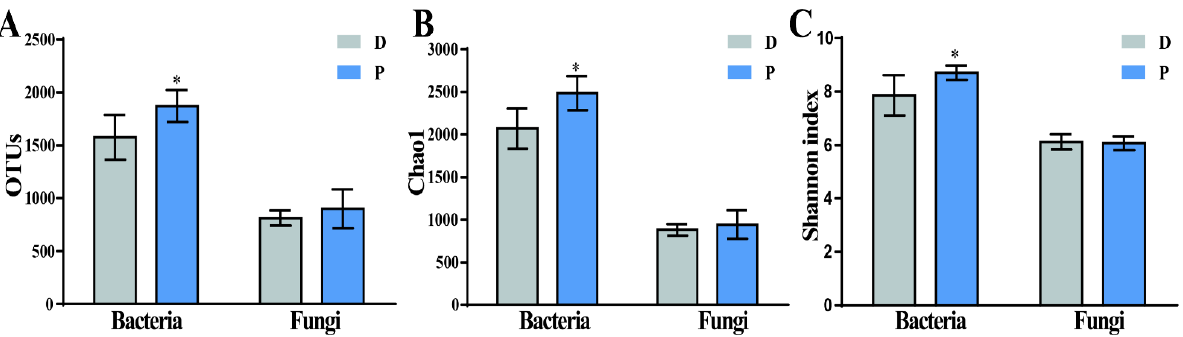
Figure 1. Effect of the fungicide prochloraz on bacterial and fungal community diversity in bayberry rhizosphere soil. ( A ) OTU distribution; ( B ) Chao1 diversity indexes; ( C ) Shannon diversity index. D and P represent decline disease alone and in combination with the fungicide prochloraz, respec- tively. * on the column indicates that the same parameter of the treatment is significantly larger than that of the control ( p < 0.05).